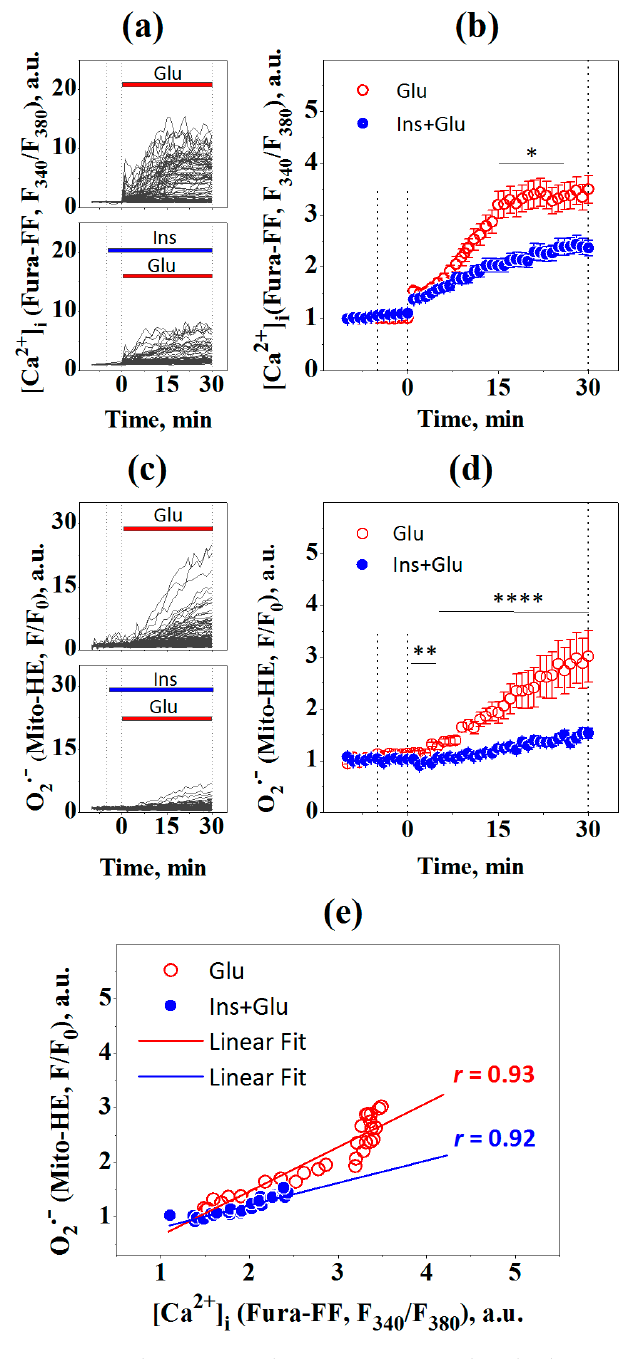
Figure 3. Insulin prevents the increase in mitochondrial superoxide ([O 2 −• ]) in glutamate-exposed rat cortical neurons. ( a ) The dynamics of Fura-FF fluorescence, a measure of [Ca 2+ ] i , in single neurons (gray lines) treated with 100 µ M glutamate (Glu; number of neurons n = 149) or 100 nM insulin and 100 µ M glutamate (Ins + Glu; n = 95). The data are obtained at every time point, at 60-s intervals, within 30 min of glutamate exposure. ( b ) The dynamics of Fura-FF fluorescence averaged over groups of neurons at every time point for a 30-min period. ( c ) Dynamic of Mito-HE fluorescence, a measure of mitochondrial superoxide, in the same single neurons, gray lines. ( d ) The dynamics of Mito-HE fluorescence averaged over groups of neurons at every time point over a 30-min period. ( e ) Pearson’s correlations between intracellular [Ca 2+ ] i means and mitochondrial superoxide of ( b , d ). Data for ( b , d ) are the mean ± SEM of the number of neurons, n. * p < 0.05, ** p < 0.01, **** p < 0.0001 (two-way ANOVA with repeated measures followed by Bonferroni’s post-test).